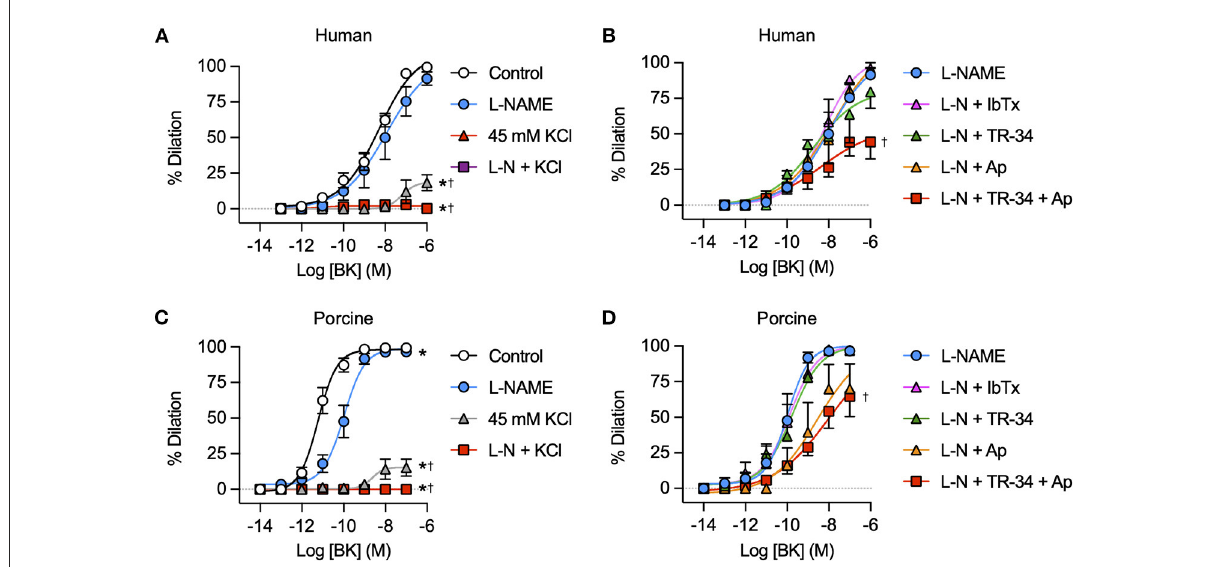
FIGURE7 K + channel mediated vasodilation of human and porcine RA-IMCAs. Concentration response curves to BK in the presence and absence of NOS inhibitor L-NAME (L-N, 100 µ M) and/or 45mM isotonic KCl and selective K Ca channel inhibitors iberiotoxin (IbTx, BK Ca , 0.1 µ M), TRAM-34 (TR-34, IK Ca , 1 µ M) and/or apamin (Ap, SK Ca , 0.1 µ M) in human (A,B) and porcine (C,D) RA-IMCAs ( n = 3-32). Non-parametric mixed effects analysis with Sidak’s multiple comparison test; * P < 0.05 vs. control; † P < 0.05 vs.